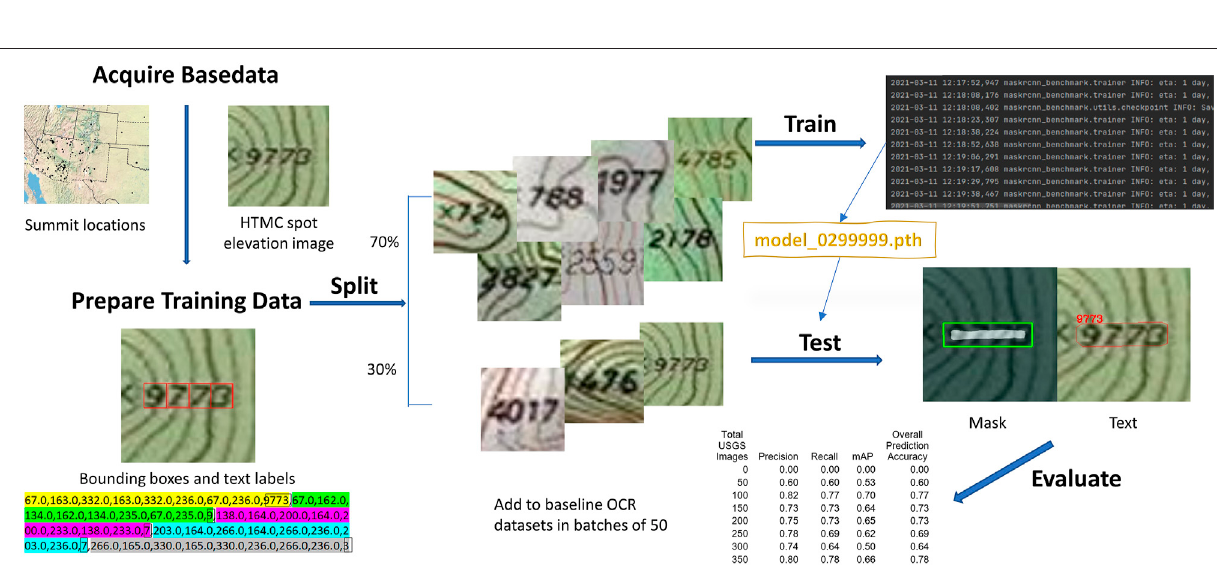
Frontiers in Environmental Science |